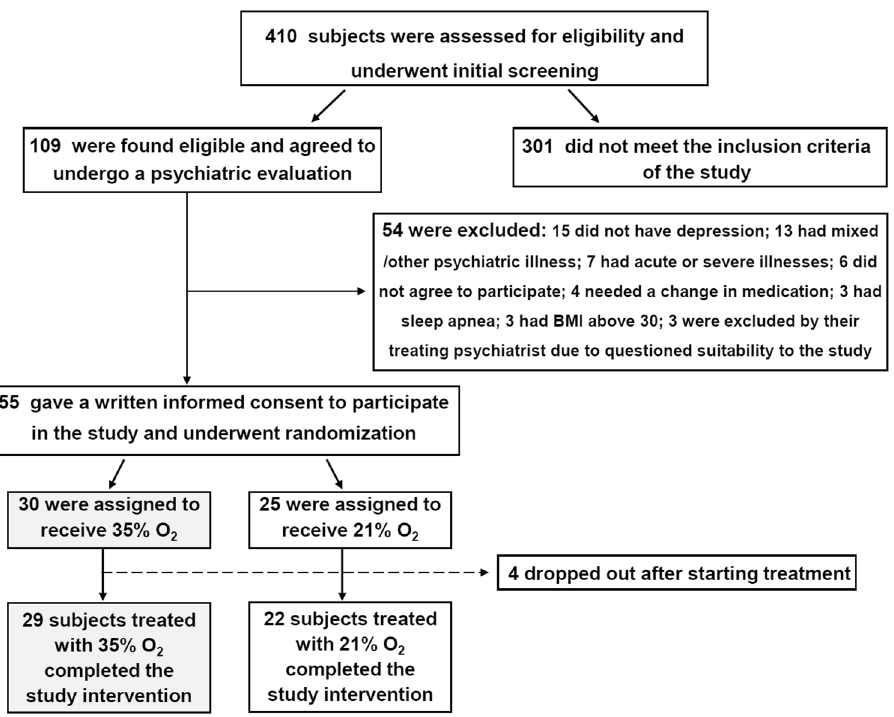
Figure 1. Screening and enrollment to the study. BMI denotes body mass index.